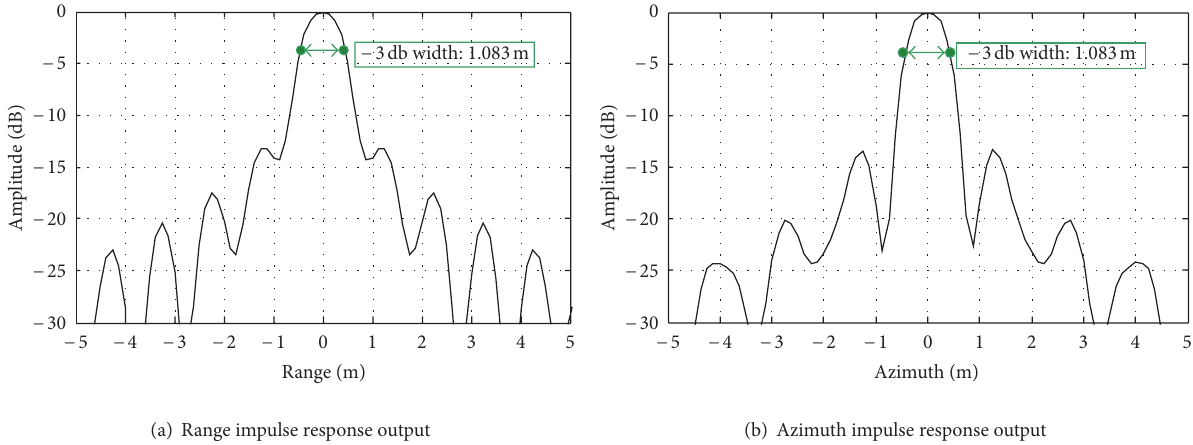
Figure 10: Range impulse response output (a) and azimuth impulse response output (b) for the point target ( 𝑡 0 = 𝑇 𝑠 /8 ).